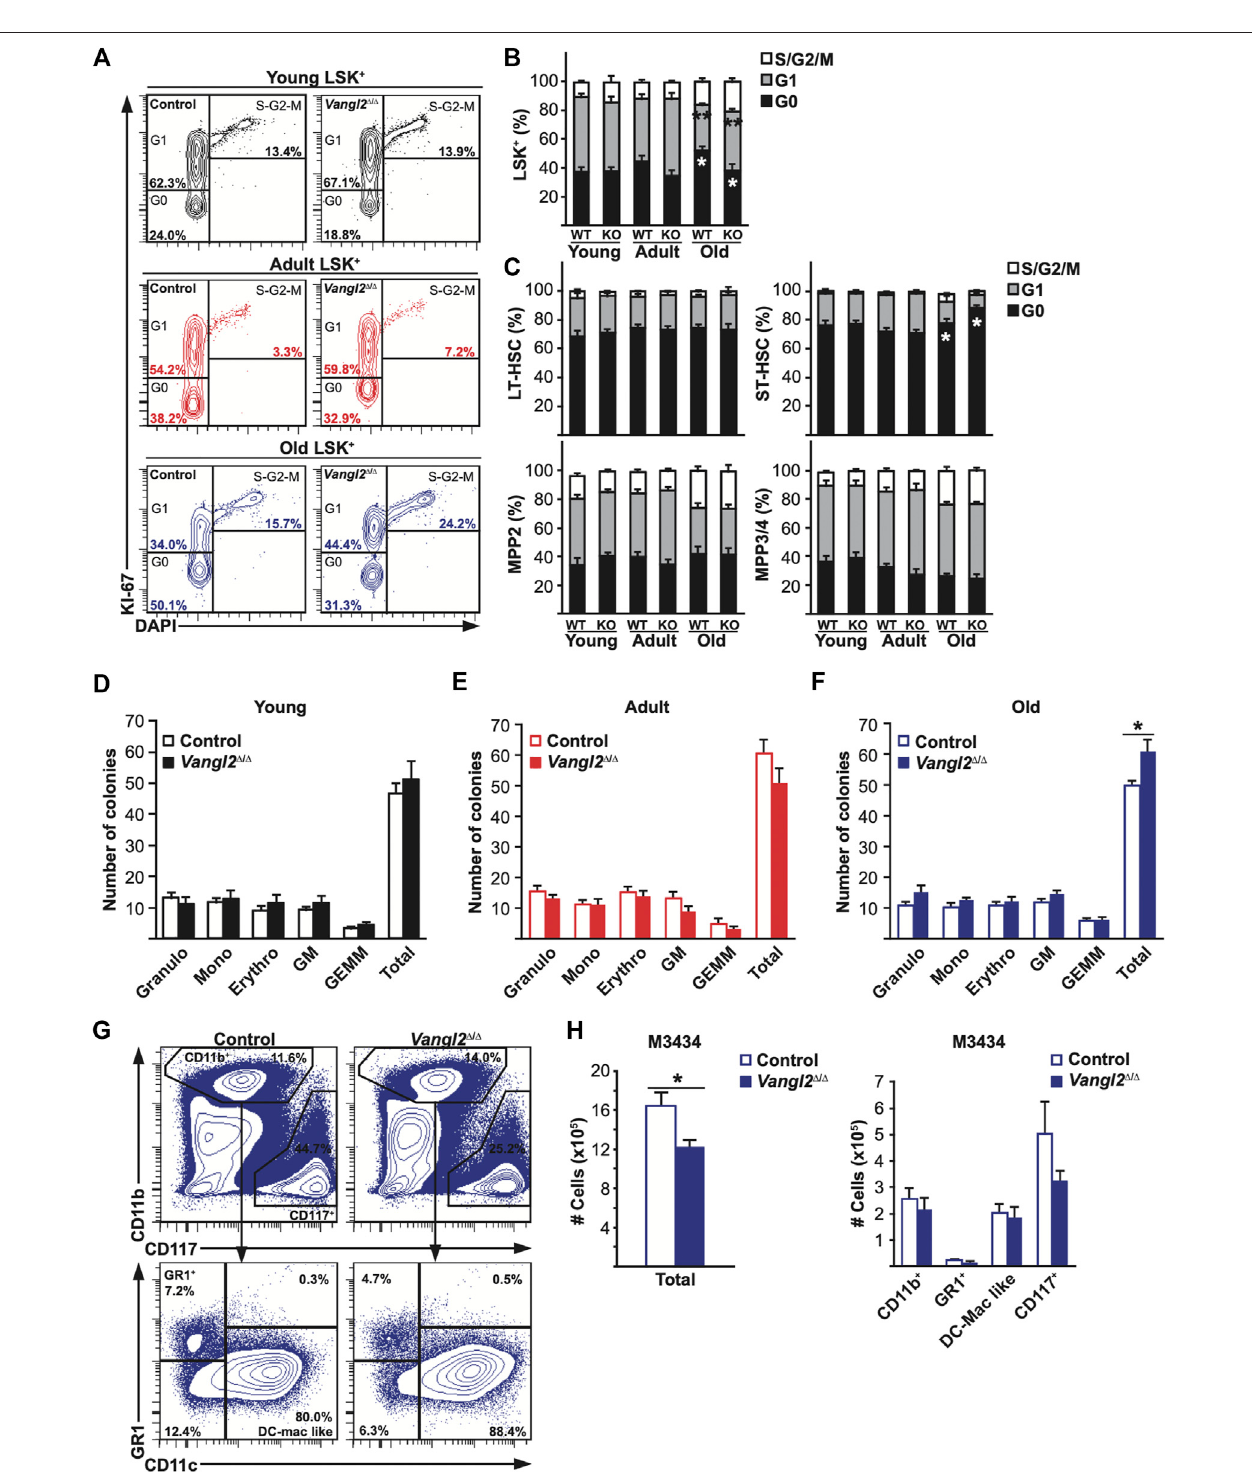
FIGURE 3 | Vangl2 loss impairs old myeloid progenitor cell expansion in vitro . (A) Representative fl ow cytometry data are shown for LSK + cells from young (2- month-old), adult (6-month-old) and old (18-month-old) mice. Numbers within panels represent G0, G1 and S-G2-M cell percentage for the panel shown. (B and C) Quantitative results of fl ow cytometry cell cycle analysis are represented for young, adult and old (B) LSK + cells and (C) LT-HSC, ST-HSC, MPP2 and MPP3/4 cells (mean +SEM). Young (n = 10 control, 12 Vangl2 Δ / Δ ), adult (n = 8 control, 10 Vangl2 Δ / Δ ), old (n = 8 control, 10 Vangl2 Δ / Δ ). (D-F) Number of colonies counted after 10 – 14 days in vitro are represented for (D) young (n = 8), (E) adult (n = 5) and (F) old (n = 5) BM cells. Granulo: granulocyte, Mono: monocyte, Erythro: erythroid, GM: granulocyte/macrophage, GEMM: granulocyte/erythroid/macrophage/megakaryocyte. (G) Representative fl ow cytometry data of harvested colony-forming units (H) Histograms represent cell numbers recovered per pooled duplicate Petri dishes seeded with BM cells from old mice (mean +SEM). * p ≤ 0.05, ** p ≤ 0.005.